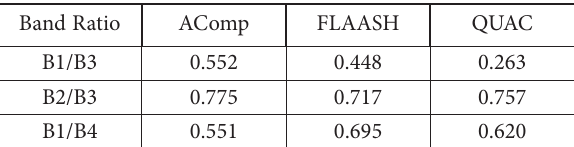
Table 1. The determination coefficient (R 2 ) of band ratios against in-situ depth